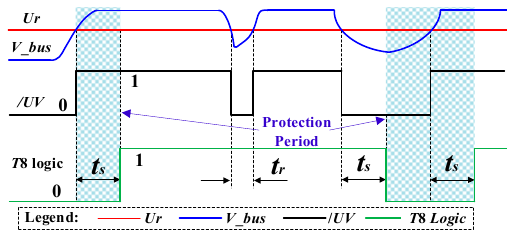
Figure 7. Bus under-voltage protection logic.